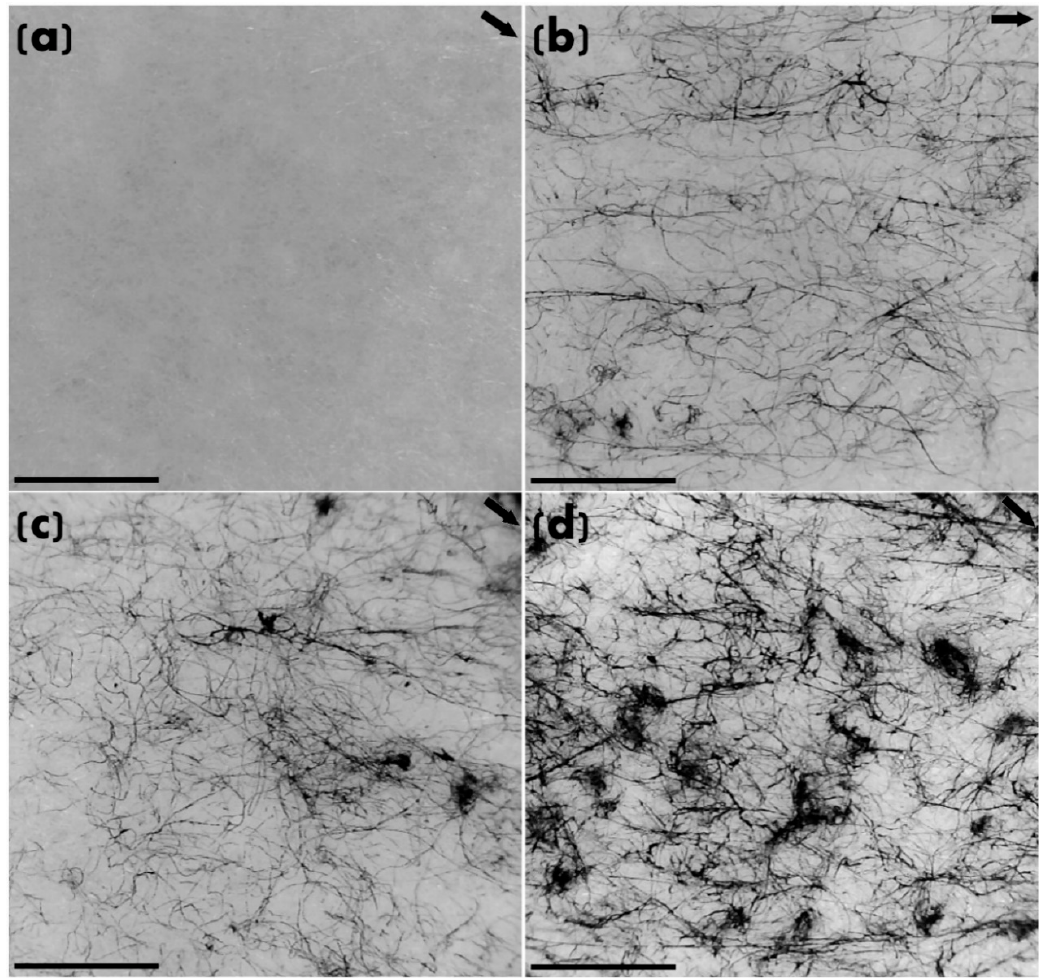
Figure 2. Representative TEM images for: ( a ) monolithic HDPE; and nanocomposites containing: ( b ) 2 wt% CNTs; ( c ) 4 wt% CNTs; and ( d ) 6 wt% CNTs. Direction of extrusion is represented by the arrow on the top right. Scale bar represents 500 nm.